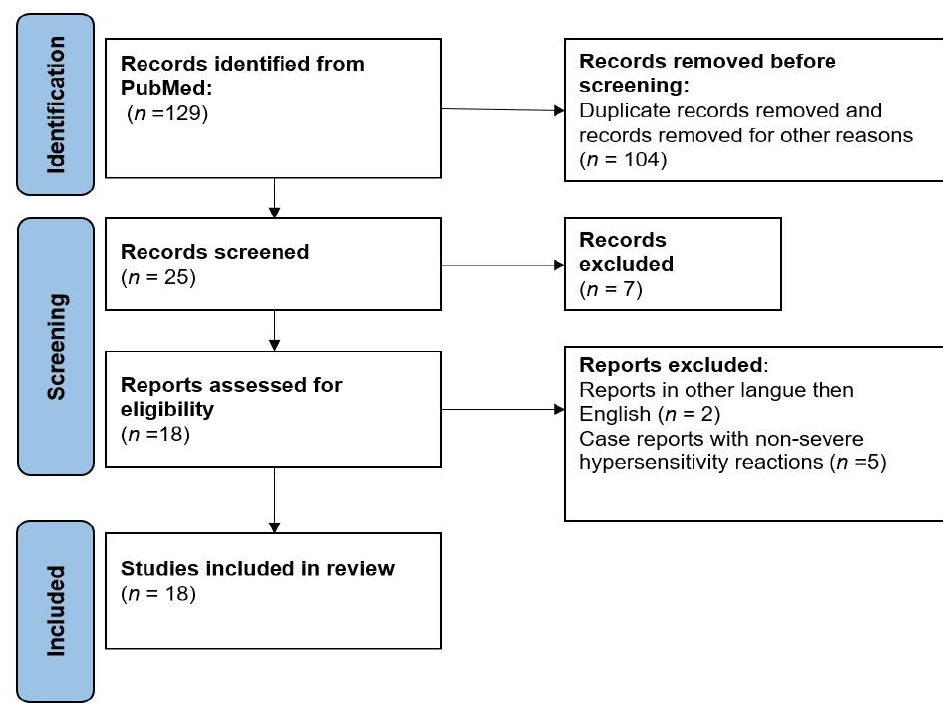
Figure 1. Flow chart showing the strategy used in this systematic review.